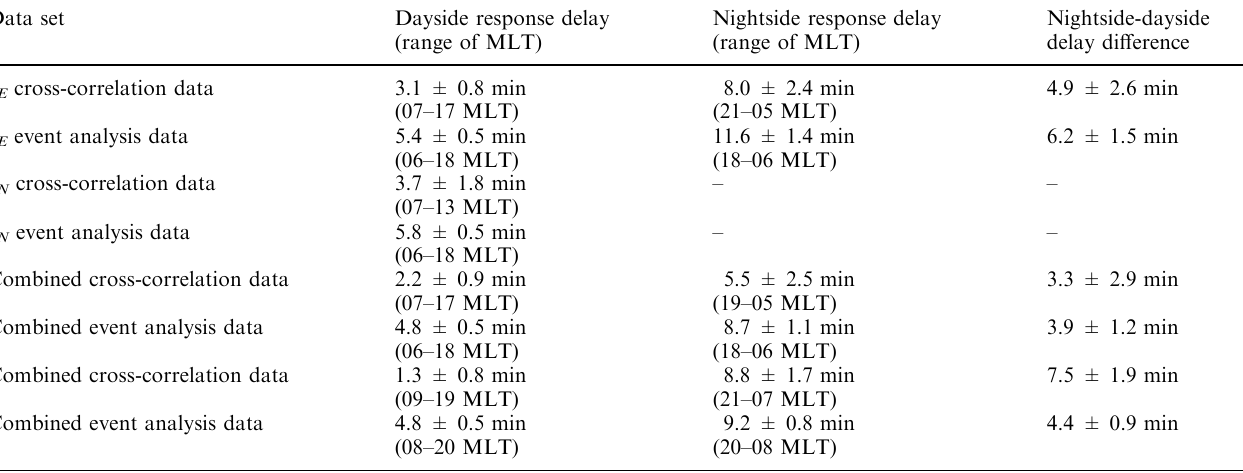
Table 1. Averaged flow response delays in di(cid:128)erent local time sectors derived from the various data sets employed in this study. For the cross-correlation results the contributing data points have been weighted according to the inverse of their uncertainty estimate Data